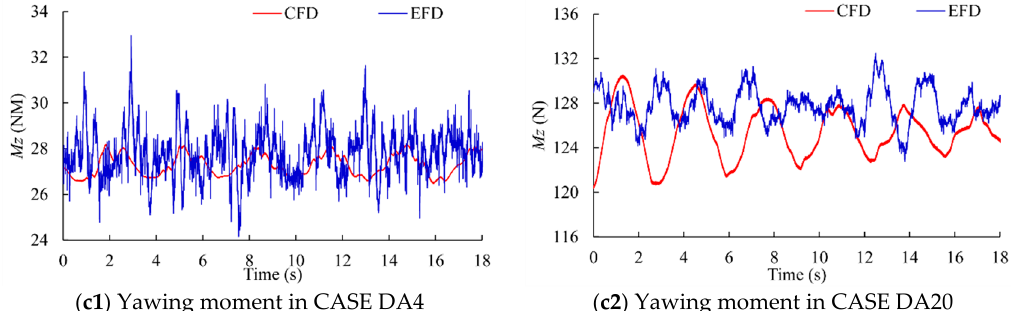
Figure 5. Forces and moments in CASE DA4 (left) and DA20 (right) (a: resistance; b: lateral force; c: yawing moment). Table 5. Comparison between the predicted and experimental forces and moment in the static drift test. CASE